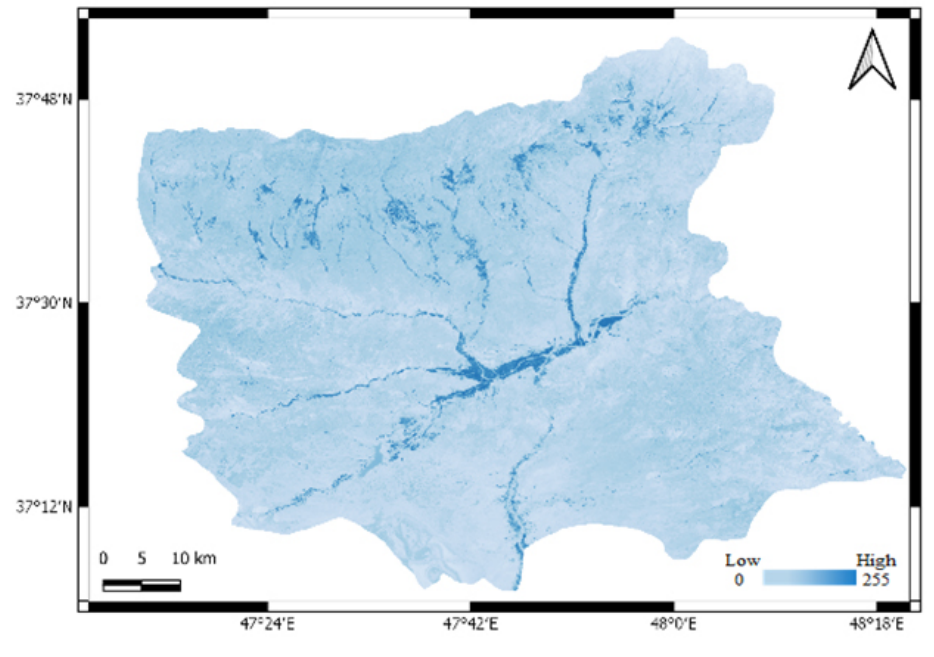
Figure 4. Soil moisture map.